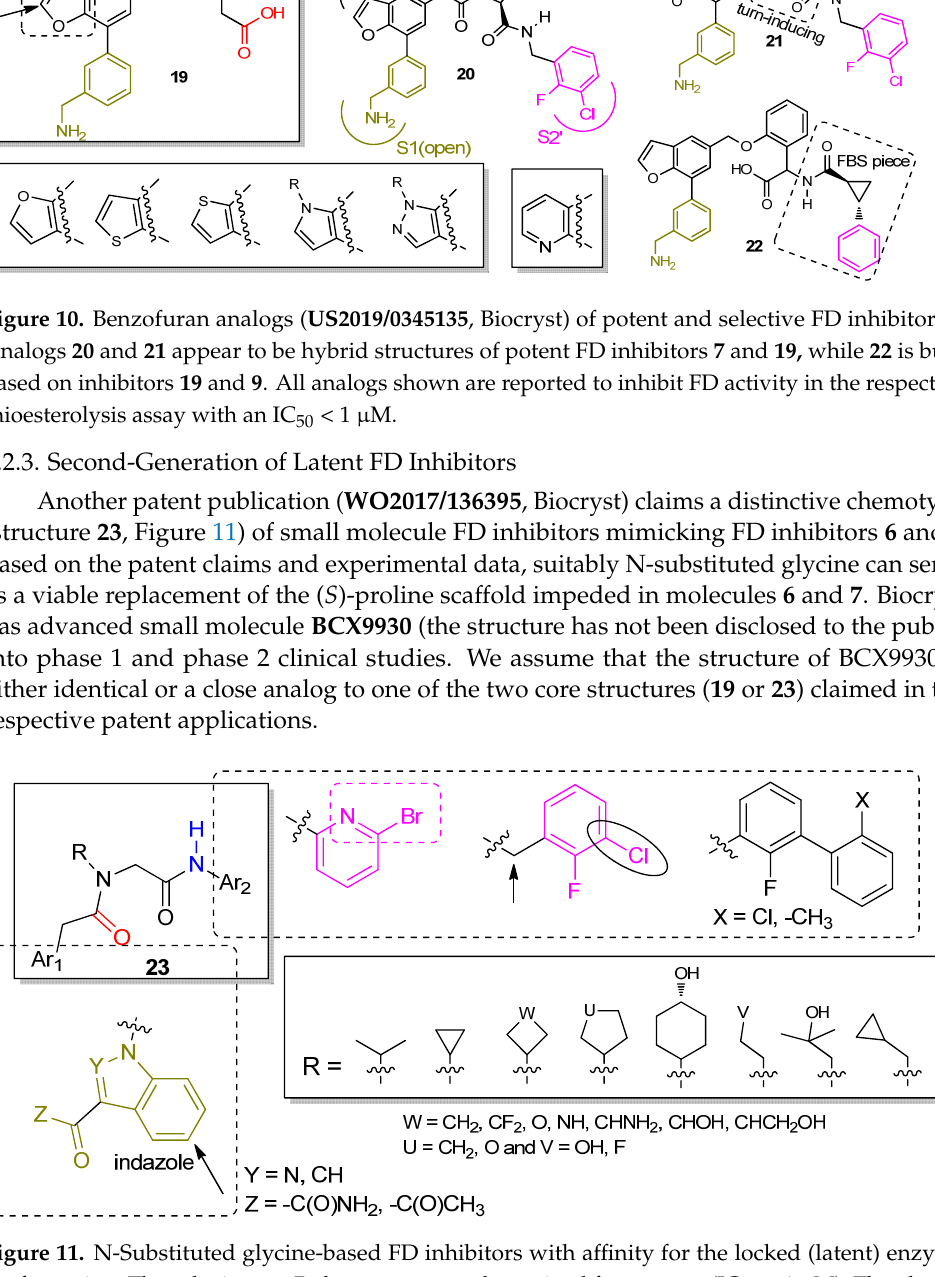
conformation. The substituents R shown appear to be optimal for potency (IC 50 < 1 µM). The glycine